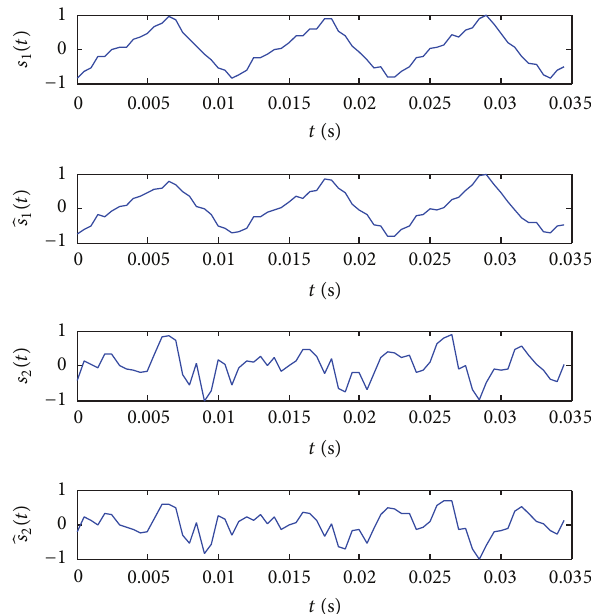
Figure 8: Practical result of proposed BSS algorithm ( 𝐿 = 70 ).